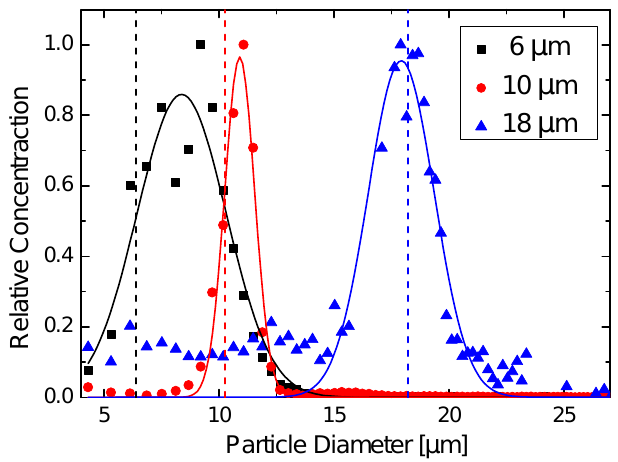
Fig. 4. Size spectra of monodisperse polystyrene latex spheres with diameters of 6 . 4, 10 . 3 and 18 . 2µm measured by HOLIMOII. For each size, a Gaussian distribution was fitted (solid lines) through the normalized measurements (points) and compared to the nominal size (dashed line).